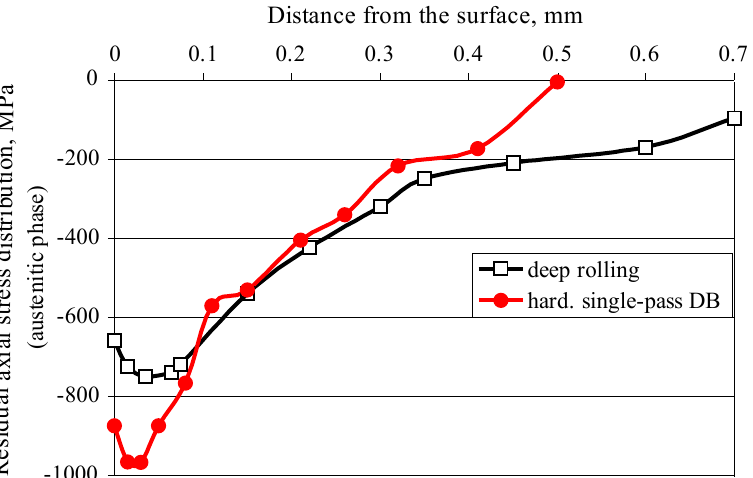
Figure 15. A comparison of the axial residual stresses measured for the austenite phase and obtained via deep rolling [26] and DB.